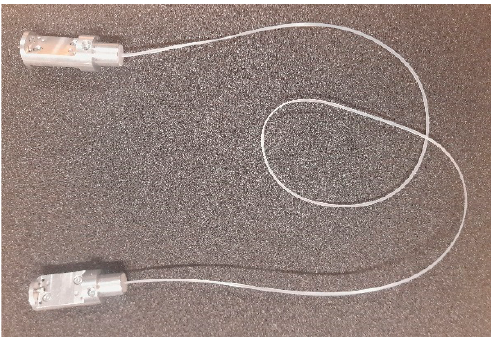
Figure 13. The polymer microwave fiber that was used in the test setup.